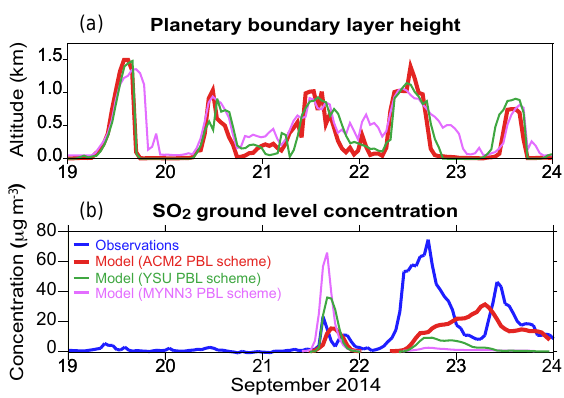
Figure 13. Time variations in Lille of modelled (top) planetary boundary layer height and (bottom) SO 2 concentration at ground- level with high spatial resolution simulations configured with YSU (green), ACM2 (red) and MYNN3 (pink) PBL parameterization schemes. The observed ground-level concentration is represented in